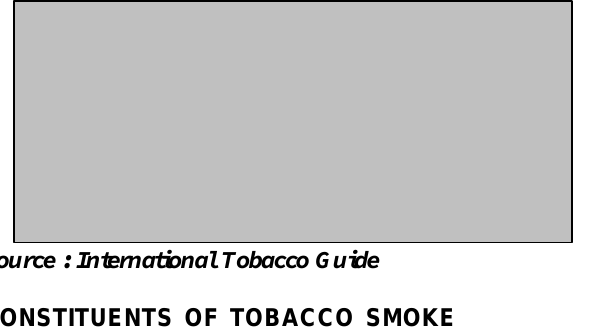
Source : International Tobacco